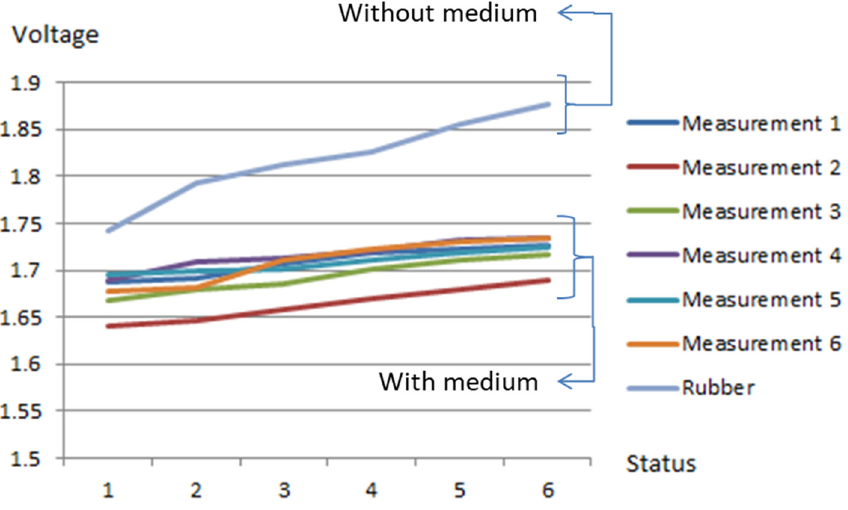
Figure 13. Tire wear result.